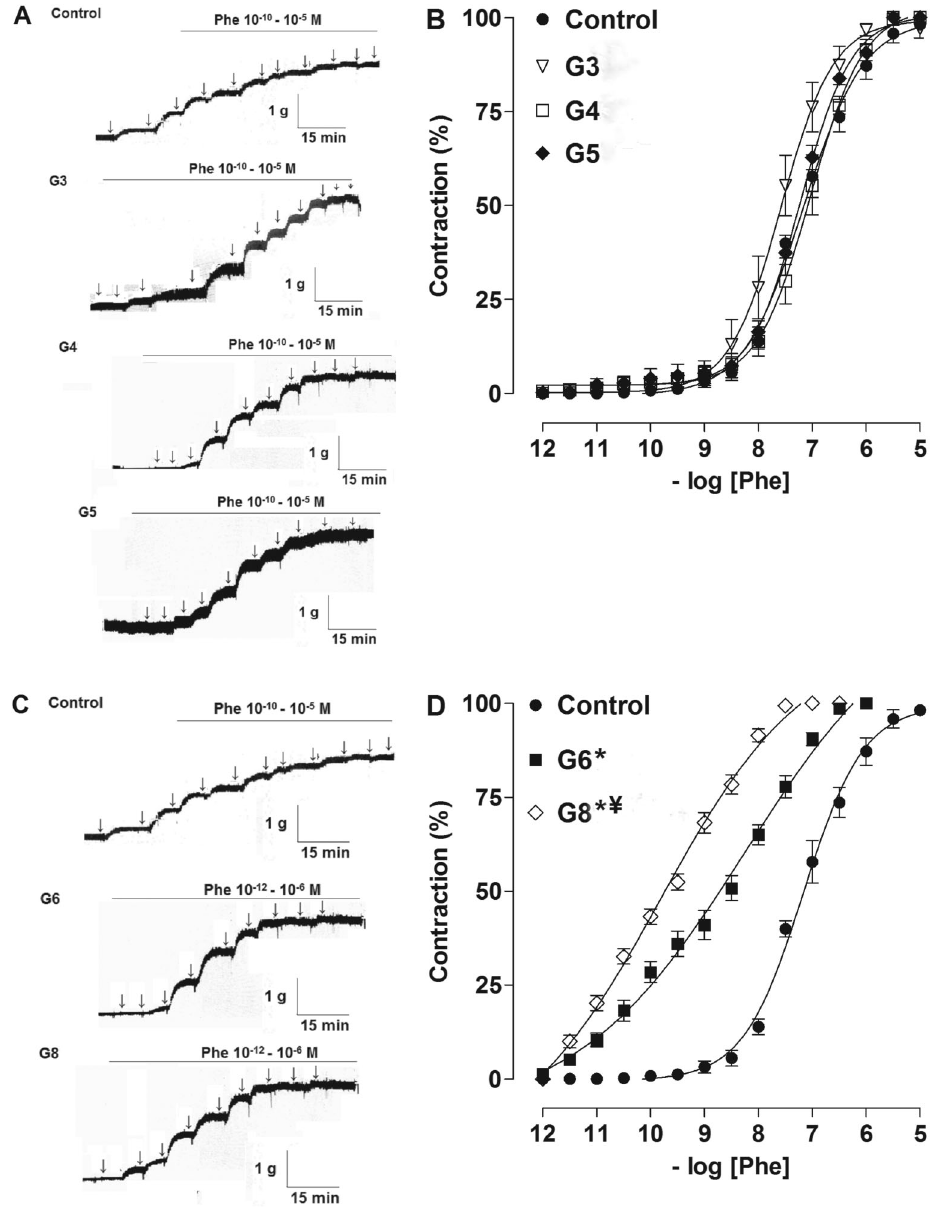
Figure 3. Representative traces and contractile response of rat aorta induced by phenylephrine in control, G3, G4, G5 ( A and B , lower intensities), and G6 and G8 ( C and D , higher intensities) groups. Data are reported as means ± SE (n=5 per group). G3, G4, G5, G6 and G8: exercise intensity based on loading with 3, 4, 5, 6 and 8% of body weight, respectively, during swimming exercise. *P o 0.05 vs control; f P o 0.05 vs G6 (one-way ANOVA). Phe: phenylephrine.